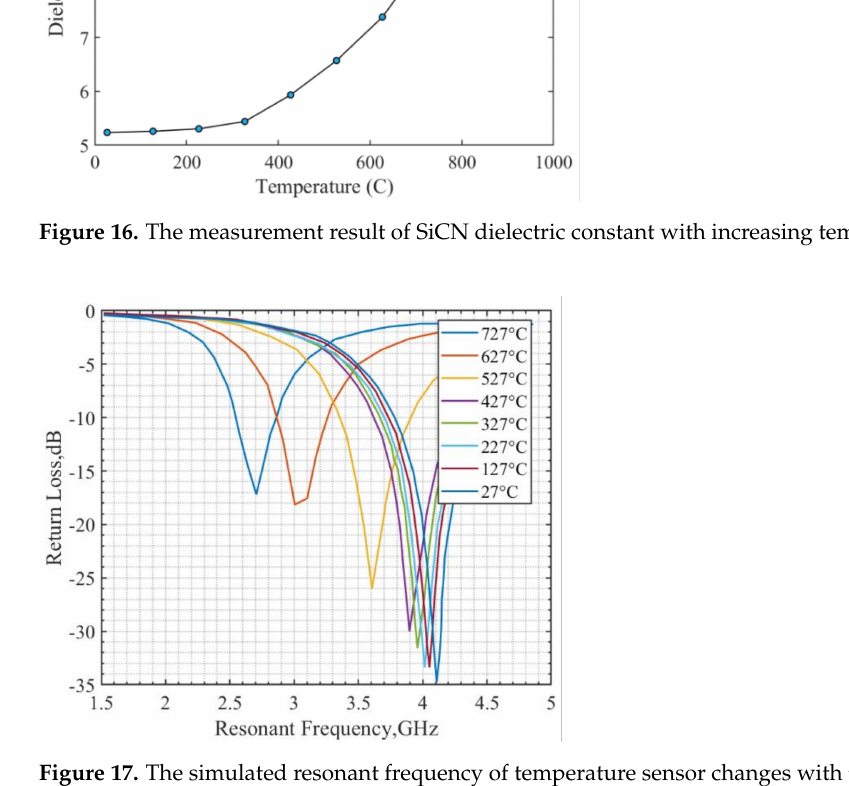
Figure 17. The simulated resonant frequency of temperature sensor changes with temperature.